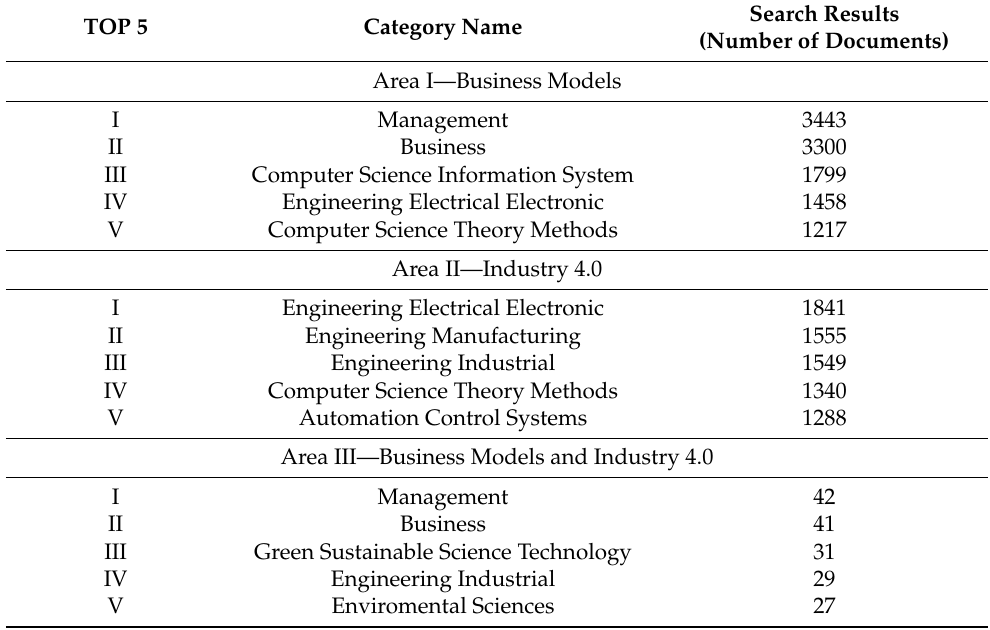
Table 4. Top 5 Web of Science categories.